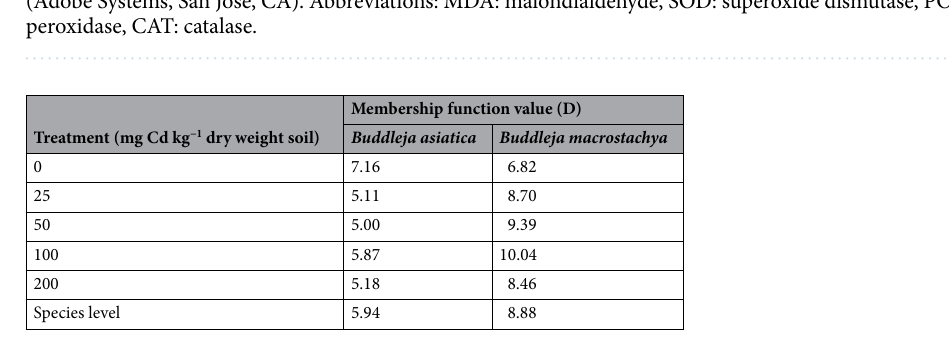
Table 2. The membership function (D) of B. asiatica and B. macrostachya under different Cd